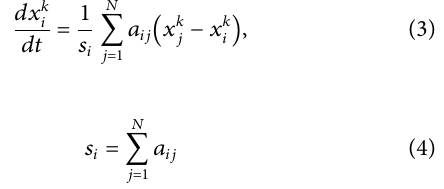
Frontiers in Physics |